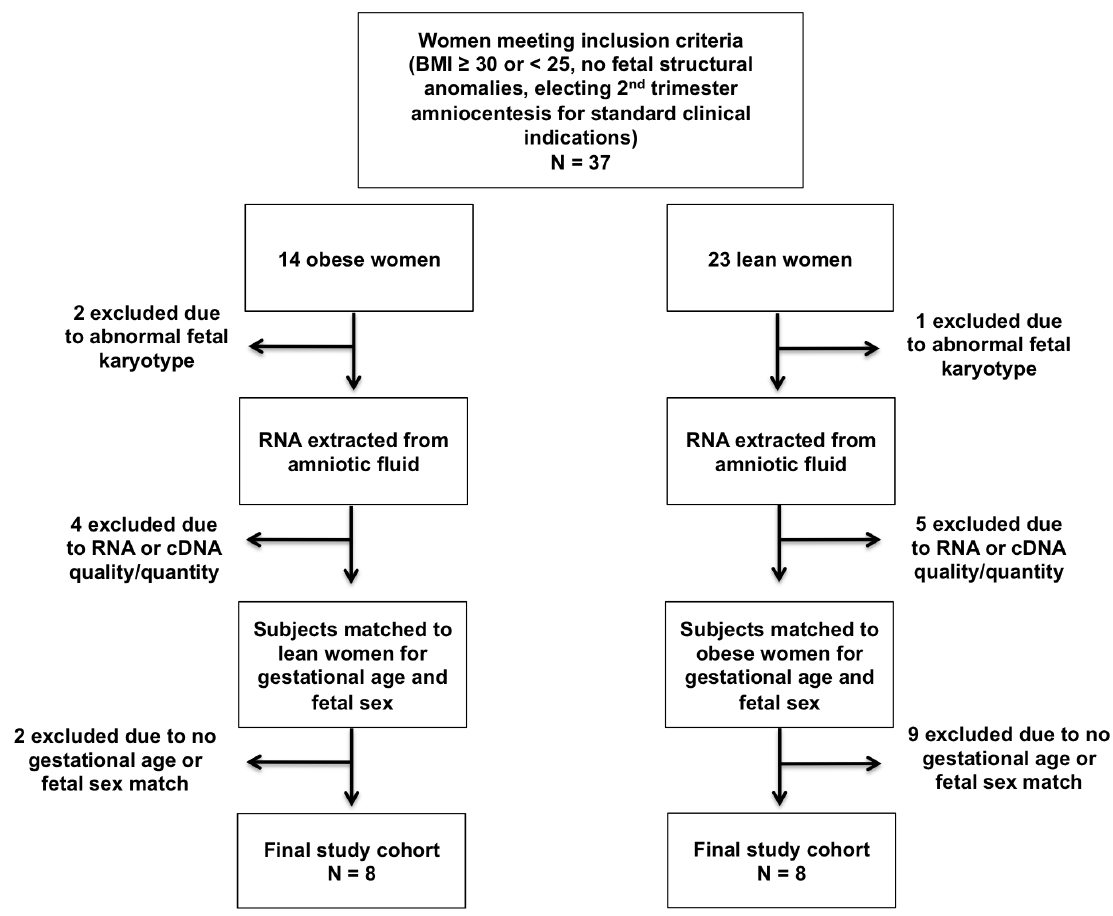
Figure 1. Flow of Subjects Through the Study. Process by which the final subjects were selected for microarray analysis.